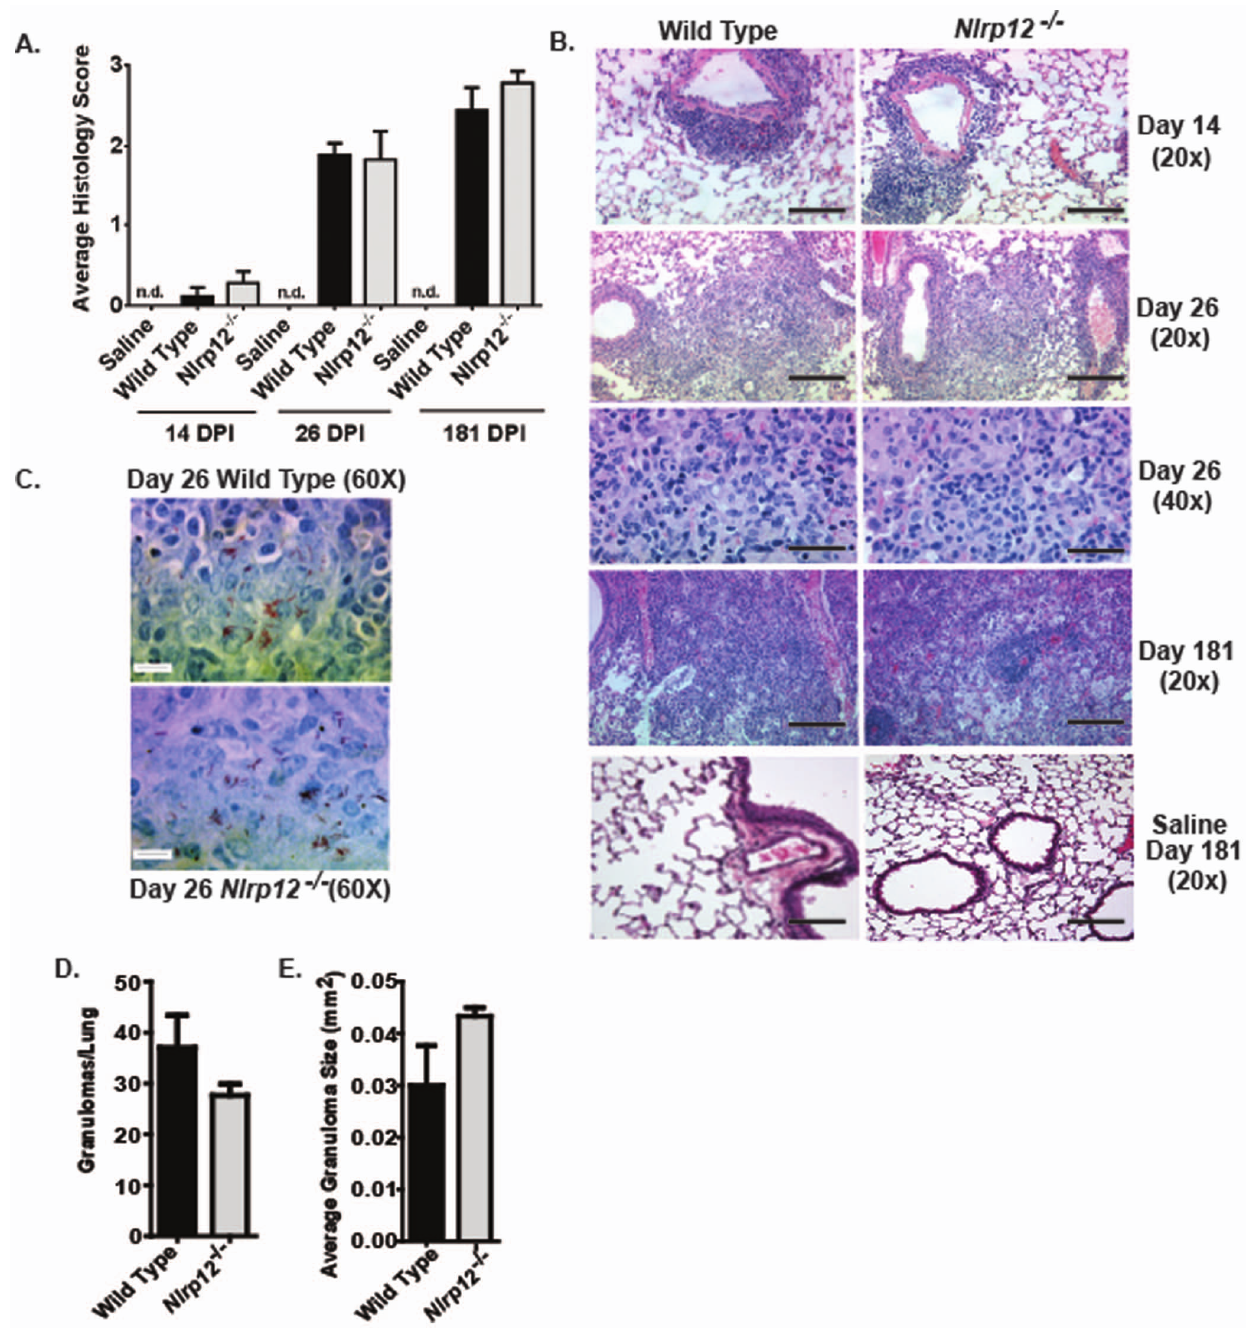
Figure 5. Lung histopathology and Mtb granuloma formation is unaltered in Nlrp12 deficient mice. Histopathological analyses of lung sections were conducted at 14, 26 and 181 days post infection (DPI) with aerosol Mtb . A) Semiquantative histology scoring revealed a similar increase in lung inflammation over the course of the Mtb infection between Nlrp12 2 / 2 and wild type mice. B) Histopathological progression of leukocyte infiltration at 14, 26 and 181 DPI. Mild to moderate perivascular cuffing was observed around the vasculature of the lungs by 14 DPI. Extensive leukocyte infiltration around the vasculature, airways and throughout the lung parachema was observed by 26 DPI. Large, well formed granulomas were observed at 181 days post infection, which affected extensive regions of the lungs. No signs of abnormal inflammation or granuloma formation were detected in the saline treated mice at any time point evaluated. The magnification bar at 20 6 =10 m M and 40 6 =5 m M. C) Images from acid fast stained lung sections revealed that the leukocyte infiltration was associated with concentrated areas of bacteria infiltration and was consistent with early stage granuloma formation. The magnification bar at 60 6 =5 m M. D–E) The number of granulomas per lung and the size of each granuloma was determined and no significant differences in granuloma formation was observed between either Nlrp12 2 / 2 or wild type mice. Experiments were repeated 2 separate times with a minimum of 12 Mtb infected Nlrp12 2 / 2 and 12 wild type mice in each group. At least 3 mice per strain per time- point were used for analysis.